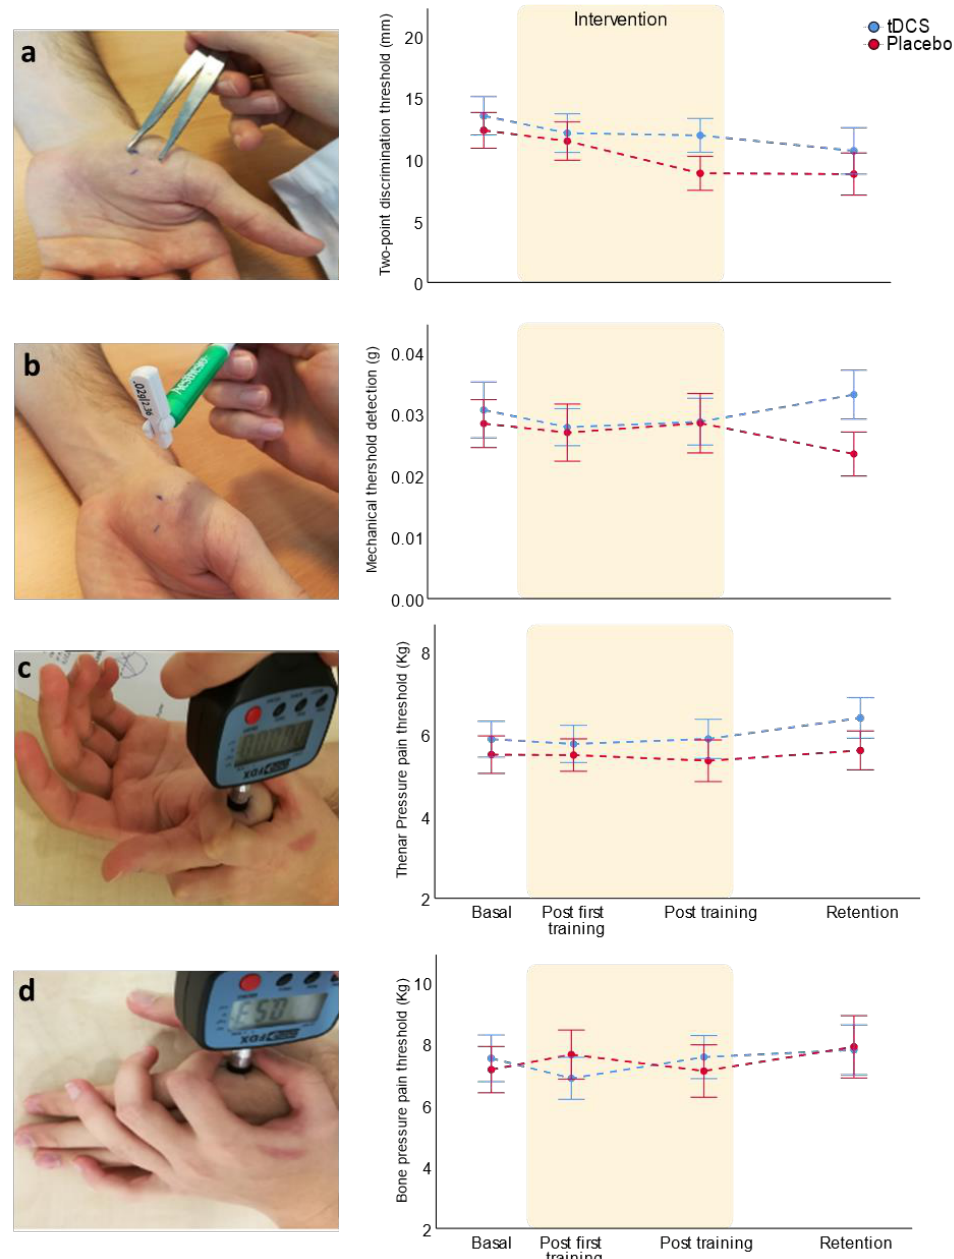
Figure 6. Bi-RP-tDCS and training effects on hand sensitivity over days: ( a ) two-point discrimination; ( b ) mechanical detection threshold; ( c ) pressure pain threshold in the thenar eminence; and ( d ) pain pressure threshold in the diaphysis of the second metacarpal bone. The data representation shows mean ± SEM.